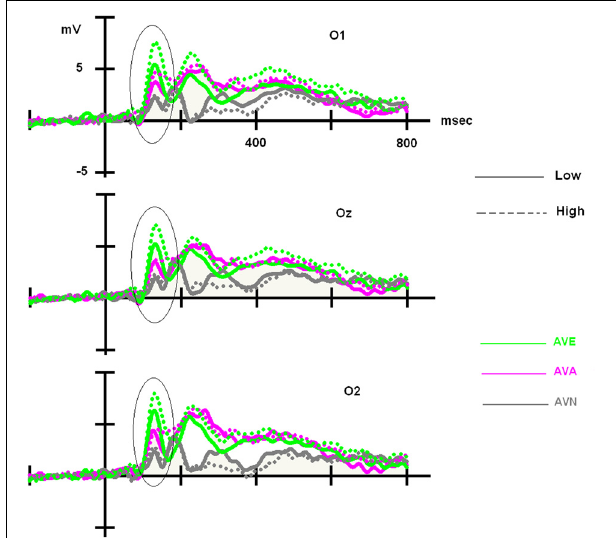
FIGURE 4 | Main effect observed on the P100 component for deviant stimuli: alexithymia-high scoring individuals displayed enhanced amplitudes for the AVE condition compared to low-scorers, while no difference emerged for the AVA and AVN conditions. Please note that independently of the group, AVE and AVA stimuli generated higher P100 amplitudes than